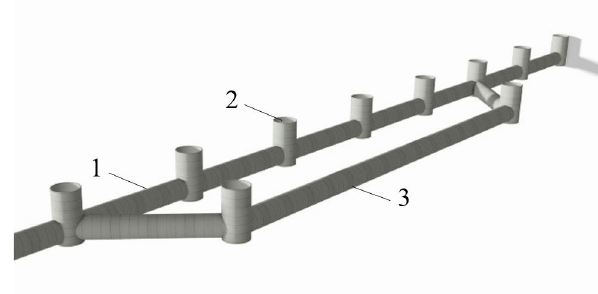
Figure 2: An example of an additional transit canal (1 – sewer canal, 2 - sewer manhole, 3 - additional transit canal) [28].